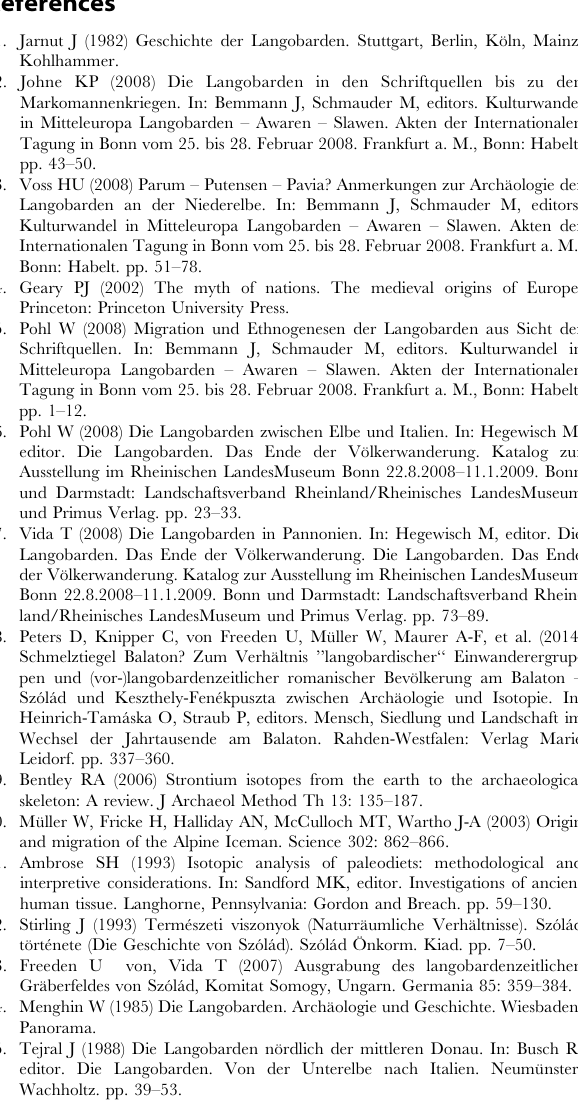
Table O, Collagen yields, nitrogen and carbon contents, atomic C/N ratios, and carbon and nitrogen isotope ratios of faunal collagen; Figure A, Sampling localities of vegetation and water samples for strontium isotope analysis. Figure S1 Map of the cemetery of Szo´la´d with indication of anthropological age and sex determinations and results of aDNA and strontium isotope